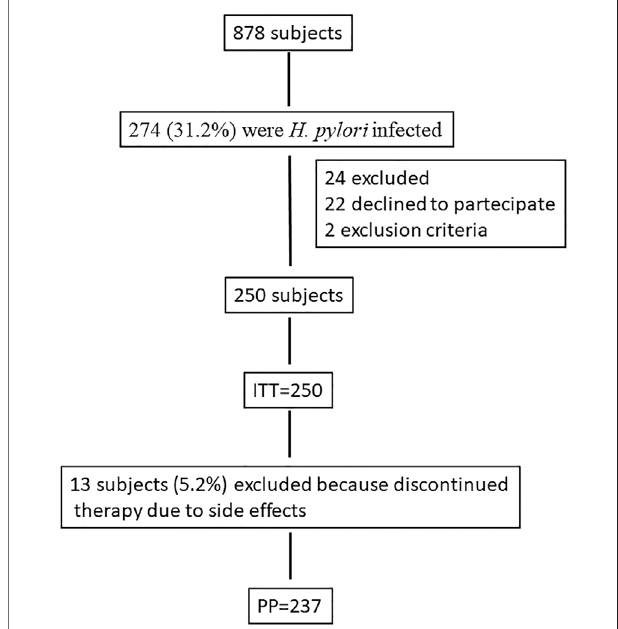
FIGURE 1 | Flow diagram of the